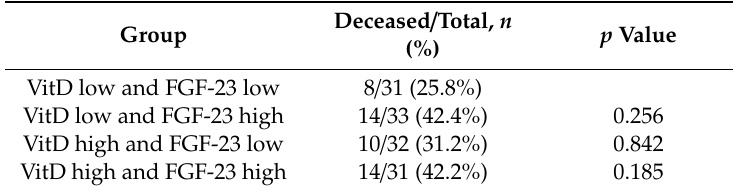
Table 4. Mortality in patients with 25-hydroxy vitamin D (VitD) and FGF-23 levels above or below the median (23.3 ng / mL and 825 RU / mL, respectively).